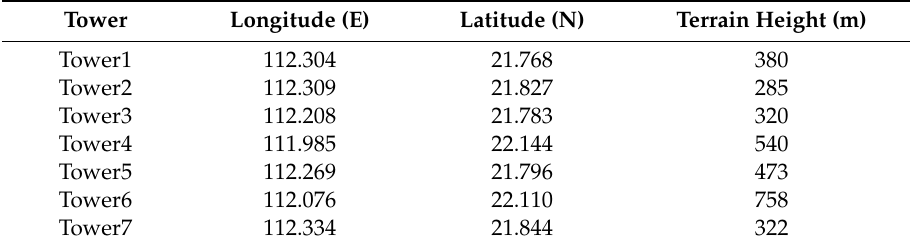
Table 1. Latitude, longitude, and terrain height of wind observation towers.